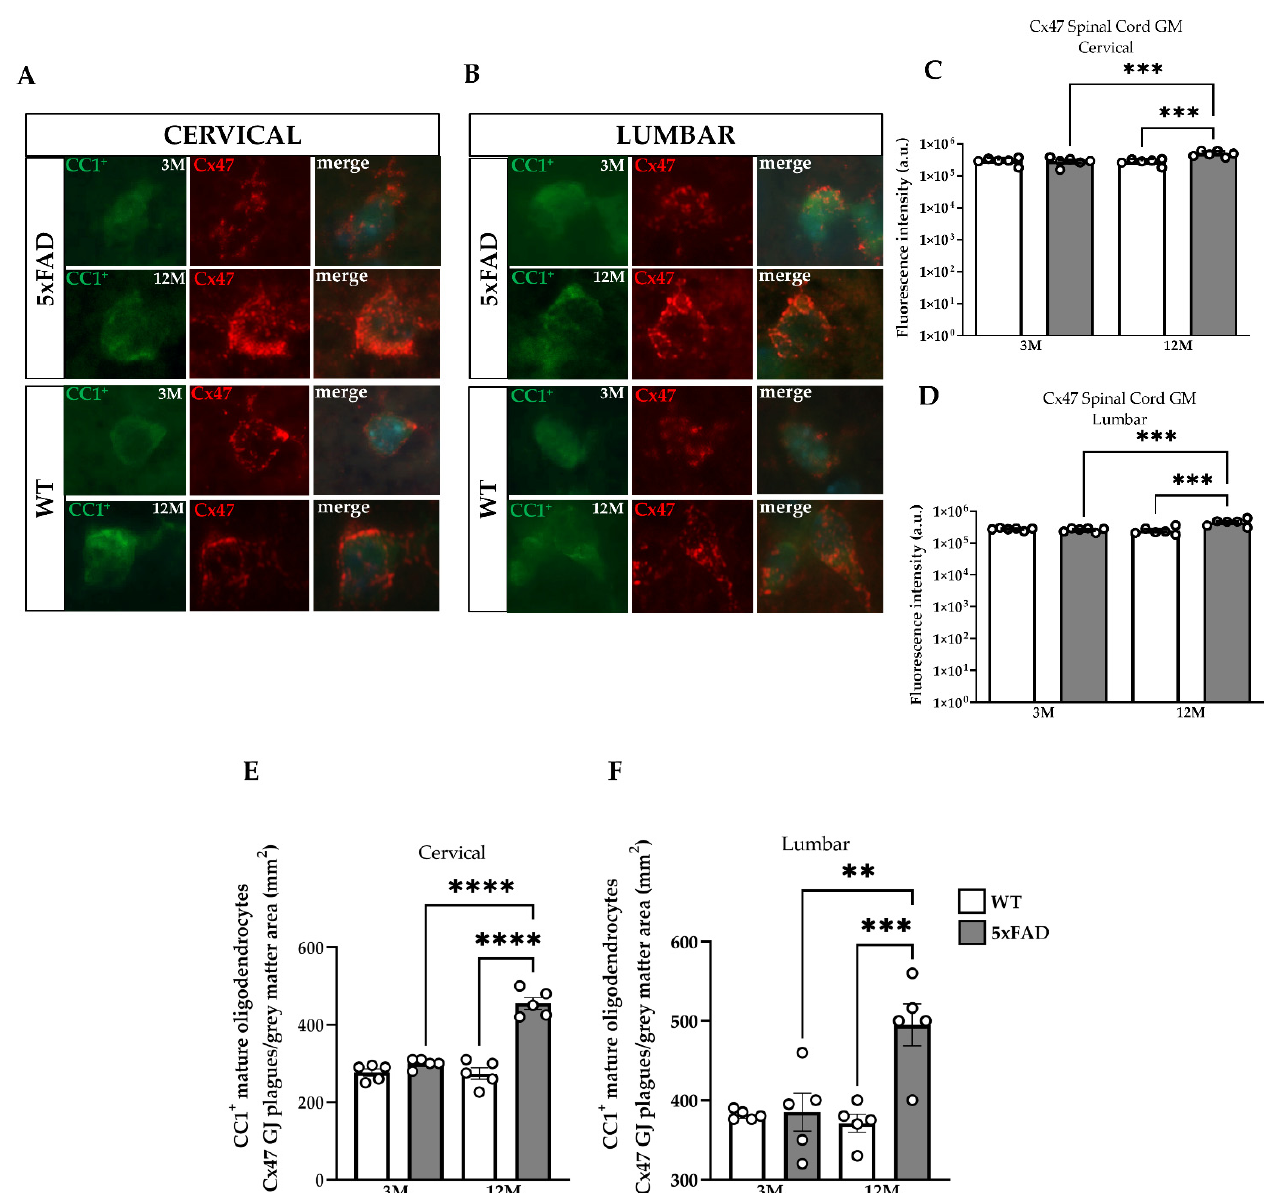
Figure 7. Increased immunoreactivity of oligodendroglial Cx47 expressed by mature oligodendrocytes within the GM of the 5xFAD spinal cord. Double immunofluorescence staining was performed ( A ) in cervical C3 and ( B ) lumbar L3 spinal cord segments from 5xFAD and WT mice using a marker for mature oligodendrocytes CC1 (green) and oligodendroglial anti-Cx47 antibody (red). Cell nuclei were counterstained with DAPI (blue). ( C , D ) Quantification of the fluorescent intensity of Cx47-positive GJ plaques in the GM of both spinal cord sections in 5xFAD and WT mice shows that immunoreactivity levels of Cx47 were significantly increased in 12M 5xFAD mice compared with the WT group and with the 3M 5xFAD group. Quantification of the mean number of CC1 + mature oligodendrocytes ( E , F ) expressing Cx47-positive GJ plaques in the GM of 5xFAD and WT mice of all ages showed increased numbers of CC1 + in 12M 5xFAD mice in both spinal cord sections in comparison with their WT littermates. The statistical analysis was performed by one-way ANOVA followed by Kruskal–Wallis multiple comparisons test ( n = 6 for all genotype and age groups). Data are presented as mean ± SD. ( A , B ) Scale bars = 10 µm. Significance is given as: ** p < 0.01, *** p < 0.001, **** p < 0.0001.